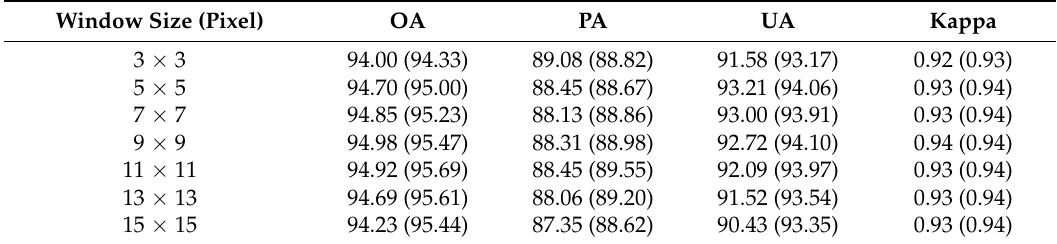
Table 5. Accuracy from textural features alone (combined spectral and textural features) across the different texture computing window